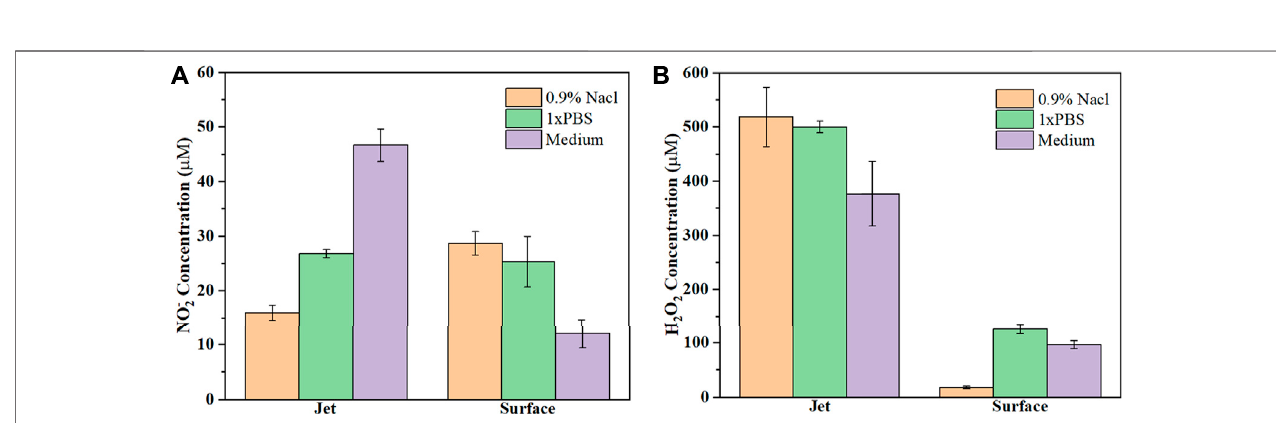
FIGURE 4 | Concentration of (A) NO 2 − and (B) H 2 O 2 in the three types of PALs. All solutions are treated by the plasma jet or surface device for 3 min.